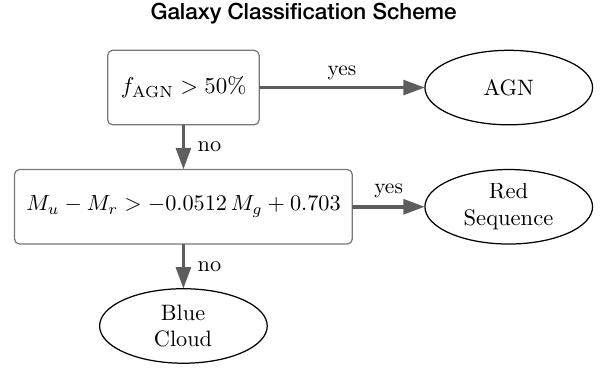
Figure 2. Simple flowchart showing how galaxies were classified into AGN, red or blue galaxies in this